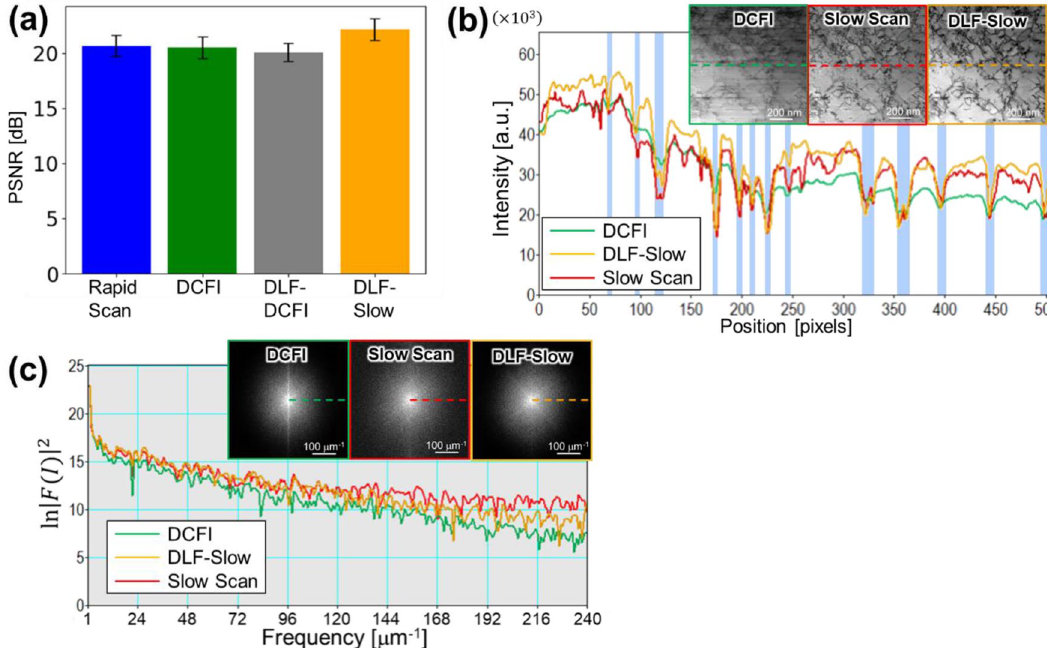
Figure 4. Evaluations of DL filtered images. ( a ) DLF-Slow images show highest PSNR to slow scan images among others, with about 7% increase in average from original rapid scan images. The little increase comes from the difference of back ground intensity as represented in ( b ) line profiles of each image. In the figure, it is demonstrated that the DLF-Slow mainly matches the intensity at the dislocation dips marked by light-blue stripes. ( c ) Line profiles of FFT spectrum image, which shows natural logarithm of power spectrum of FFT processed image F ( I ), represents good agreement between the slow scan image and the DLF-Slow image within the low frequency region up to 120 µ m −1 , while the line profile of FFT spectrum in the DCFI image is little agreement with that in the slow scan